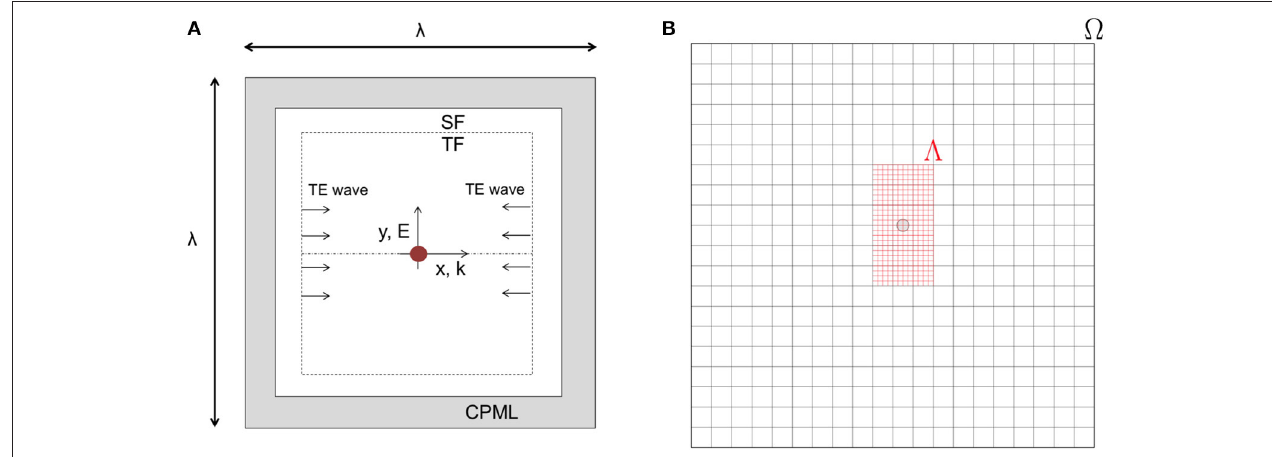
FIGURE 6 | Schematic representation of the 2D computational domain (A) and illustration of the used grid constellation (B) nested Cartesian grids.